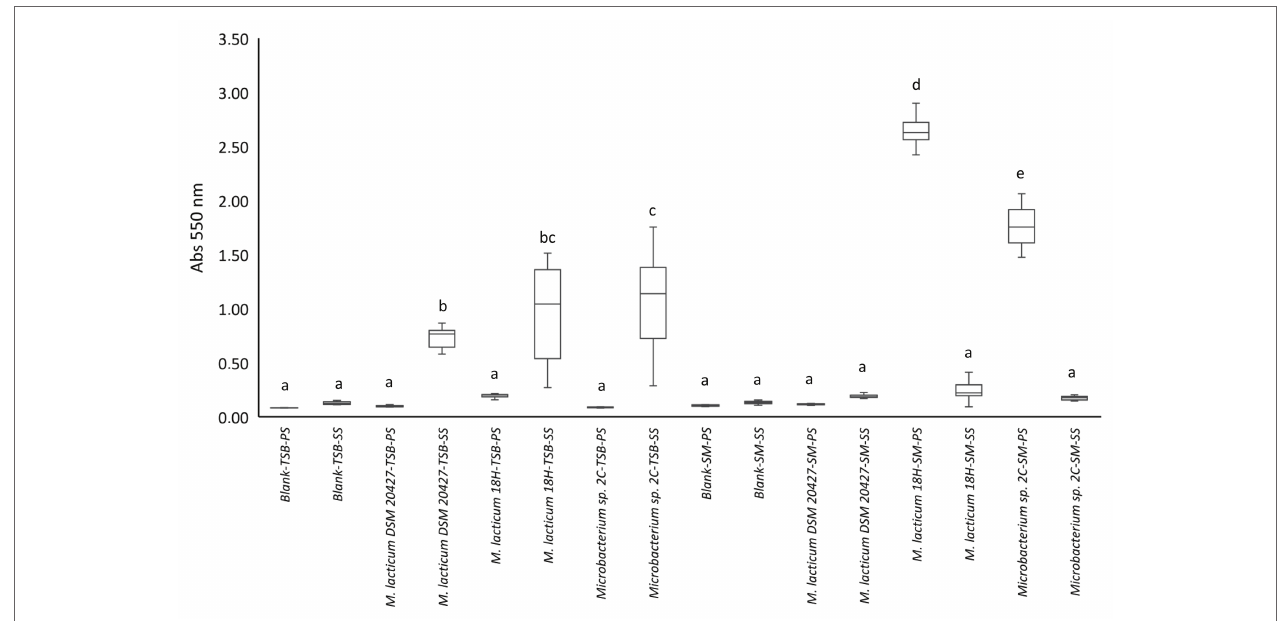
FIGURE 2 | Crystal violet staining quantification by measuring absorbance (Abs 550 nm ). Values <0.1 represent no biofilm formation; values between 0.1 and 0.25 indicate a low biofilm formation; values between 0.25 and 0.6 indicate a medium biofilm formation, whereas values >0.6 represent a high biofilm formation. PS, polystyrene; SS, stainless steel; TSB, tryptic soy broth; SM, skim